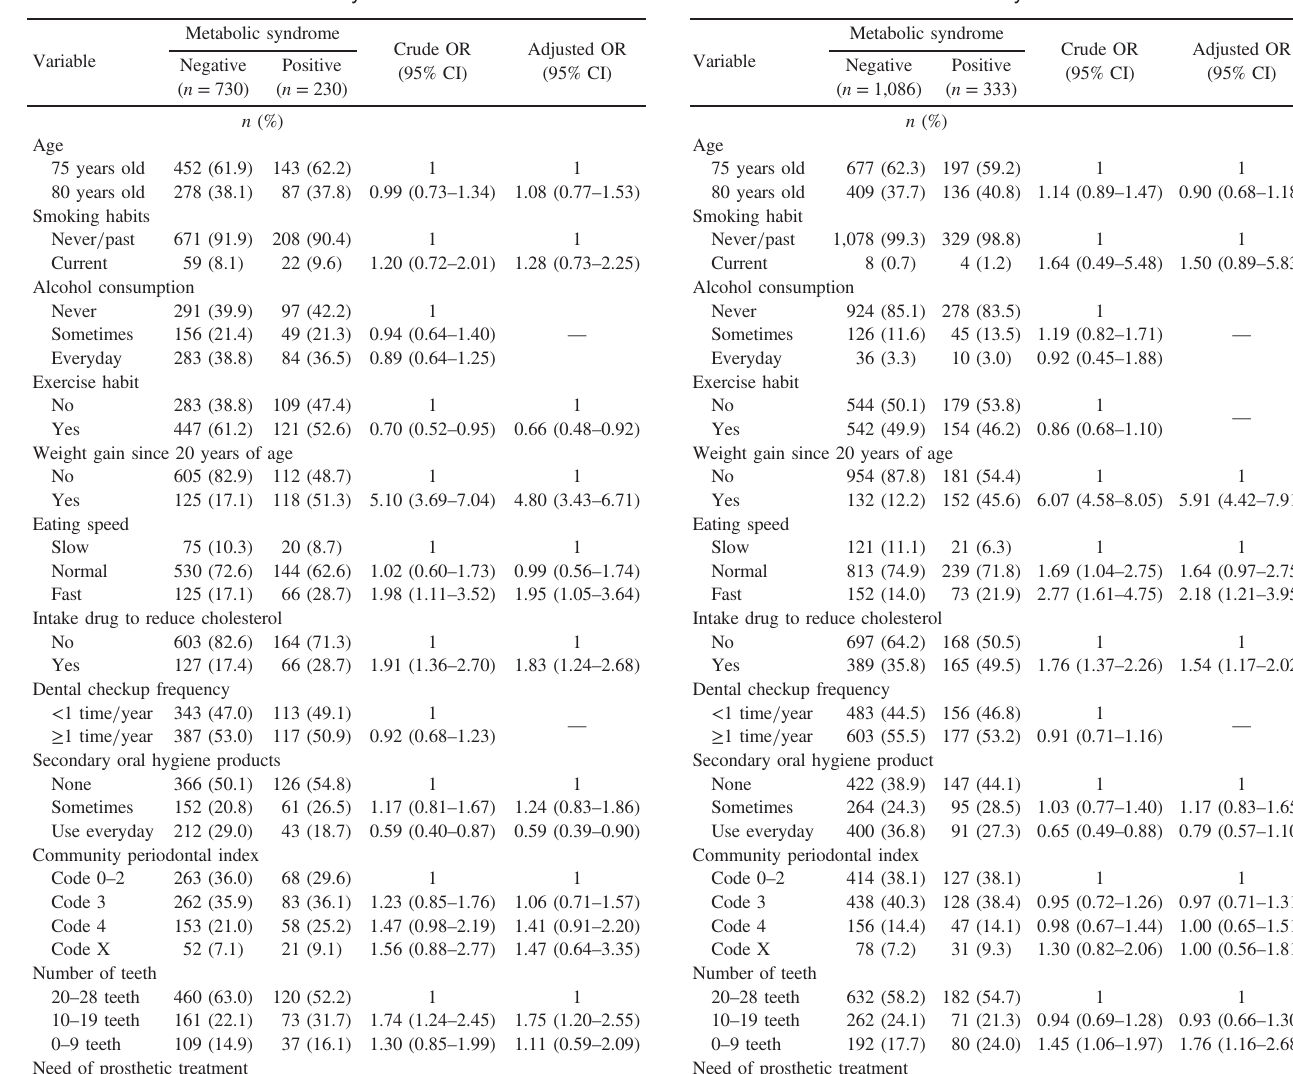
Table 4. Relation of oral health, life-style factors, and